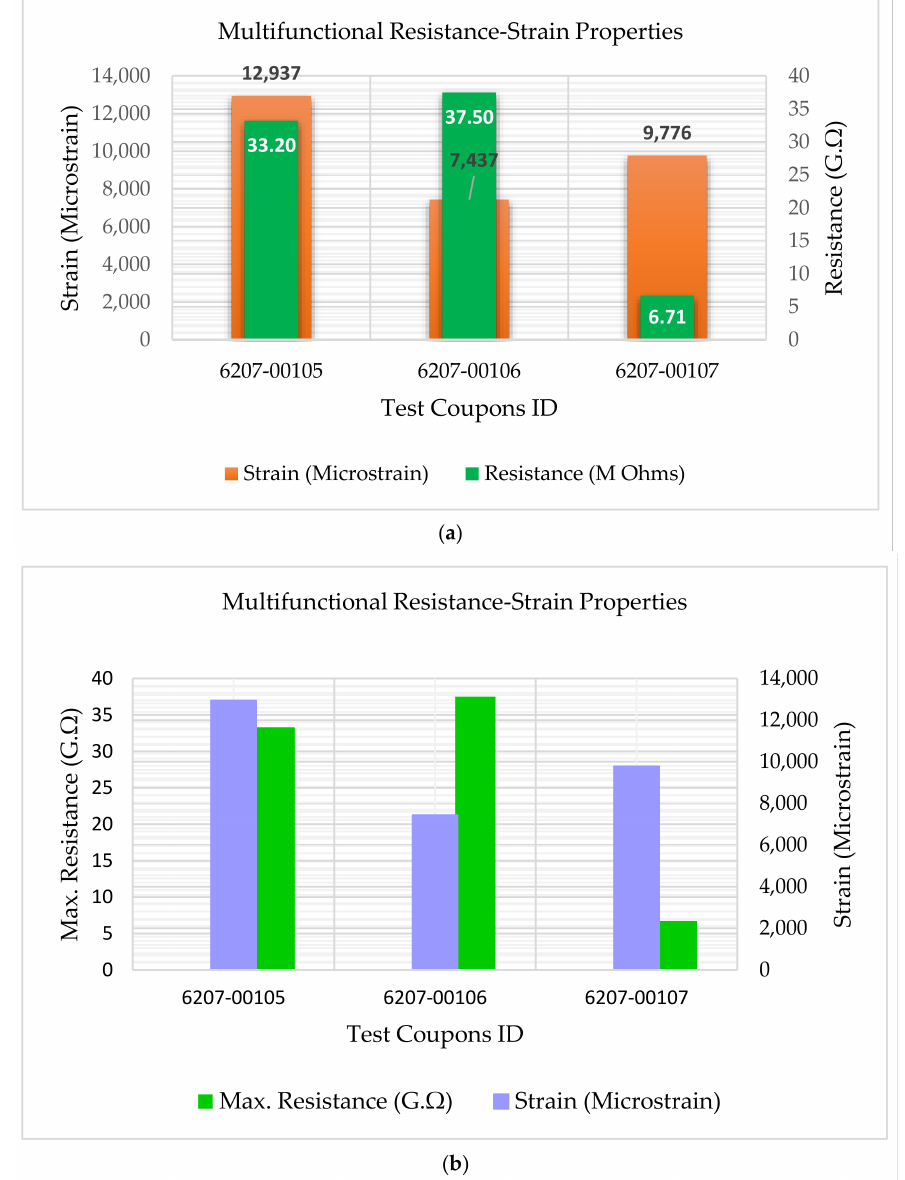
Figure 13. Coupled multifunctional resistance-strain properties comparison of test coupons: ( a ) superimposition of resistance and strain; ( b ) side-by-side